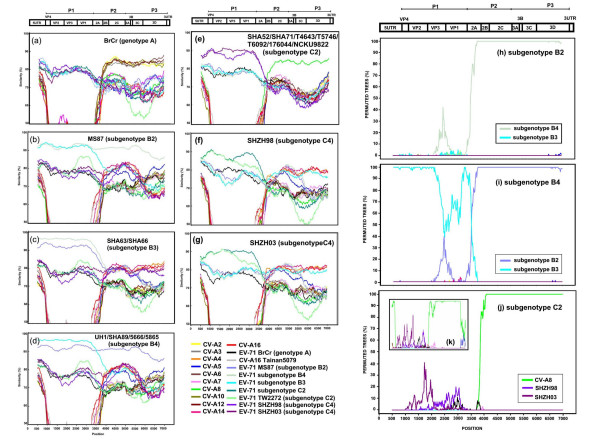
Emergence of EV-71 subgenotypes by recombination with other HEV-A viruses. Similarity plot analyses were performed using the full genome sequence of all EV-71 genotypes and subgenotypes. The sequences were queried against all other available HEV-A viruses. The nucleotide sequence of BrCr, genotype A (a), nucleotide sequence of MS87, subgenotype B2 (b), consensus nucleotide sequence of subgenotype B3 (c), consensus nucleotide sequence of subgenotype B4 (d), consensus nucleotide sequence of subgenotype C2 (e) SHZH98, subgenotype C4 (f) and SHZH03, subgenotype C4 (g) were used in the similarity plot analyses. Results from the bootscan analyses indicate the likelihood of clustering of subgenotype B2 isolate, MS87 (h), subgenotype B4 (i) and subgenotype C2 (j) isolates with their respective potential parental isolates. A sliding window of 1000 nucleotides was moved in increments of 20 nucleotides at a time. All gaps were stripped and the sequences were corrected for multiple substitutions. A transition to tranversion ratio of ten was used and 50% consensus files were used to exclude the poorly conserved sites. The subgenotype C2 isolates (k) were also queried against other HEV-A viruses using a window size of 400 nucleotides in increments of 20 nucleotides per slide. Bootstrap values of > 70% were used to indicate robust support for the tree topology [43]. The different HEV-A viruses and EV-71 genotypes are represented by the different line colors.